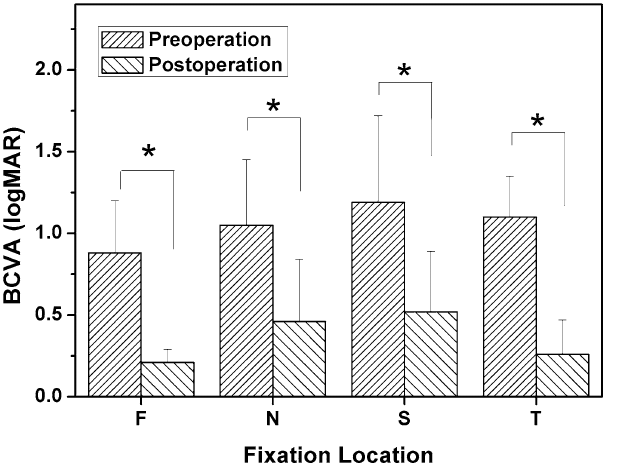
Figure 3. Comparison of preoperatively and postoperatively best corrected visual acuity (BCVA) between different groups according to the preoperative fixation location (F: foveola fixation group; N: nasal fixation group; S: superior fixation group; T: temporal fixation group).